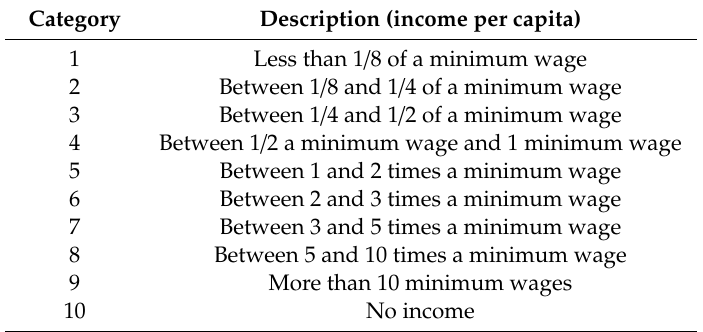
Table 2. List of income categories from the census of Brazil (Censo